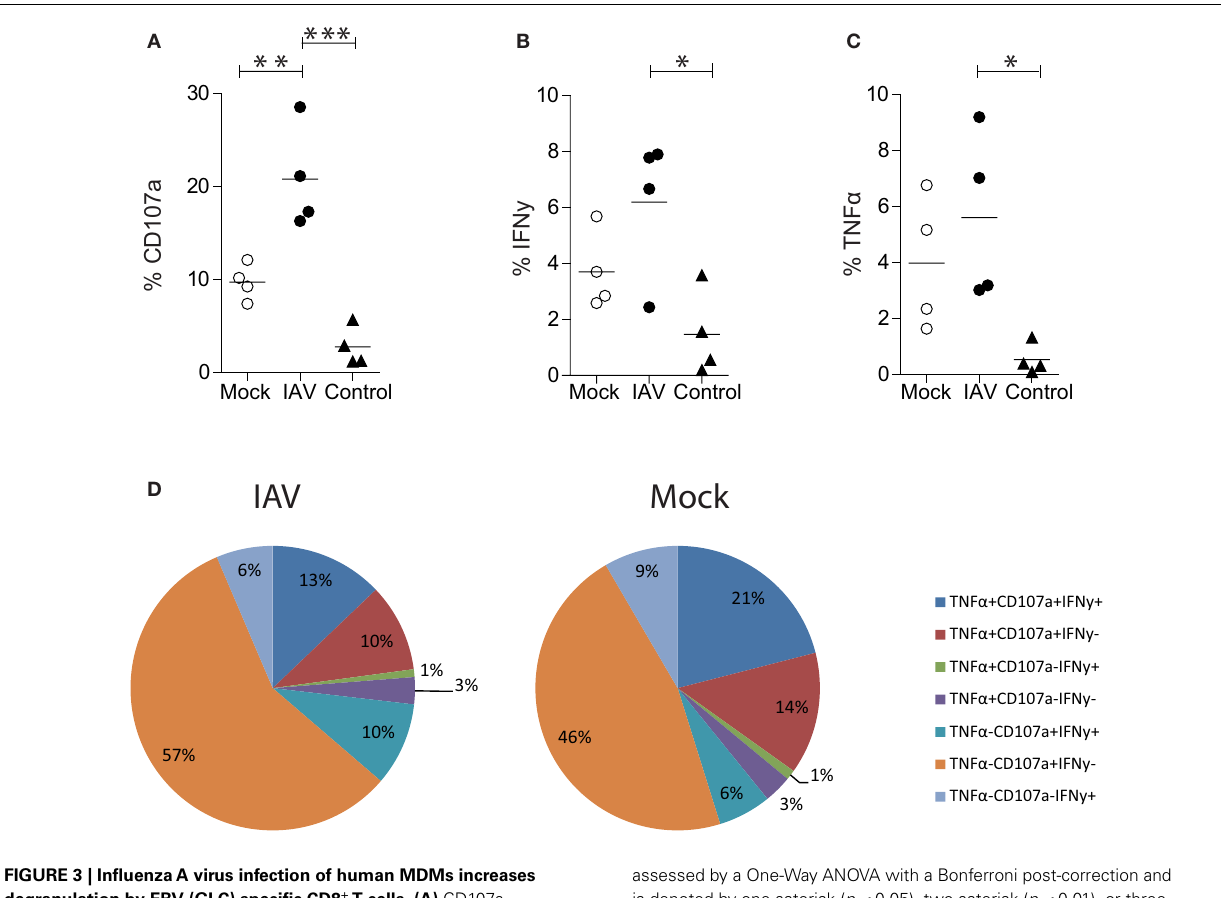
assessed by a One-Way ANOVA with a Bonferroni post-correction and is denoted by one asterisk ( p < 0.05), two asterisk ( p < 0.01), or three asterisks ( p < 0.001). (D) Polyfunctionality of CD8 + T cells following 6h stimulation with peptide-pulsed MDMs. CD3 + CD8 + T cells expressing/producing combinations of CD107a, IFN- γ , andTNF- α from four independent donors are averaged and represented as a proportion of CD3 + CD8 + T